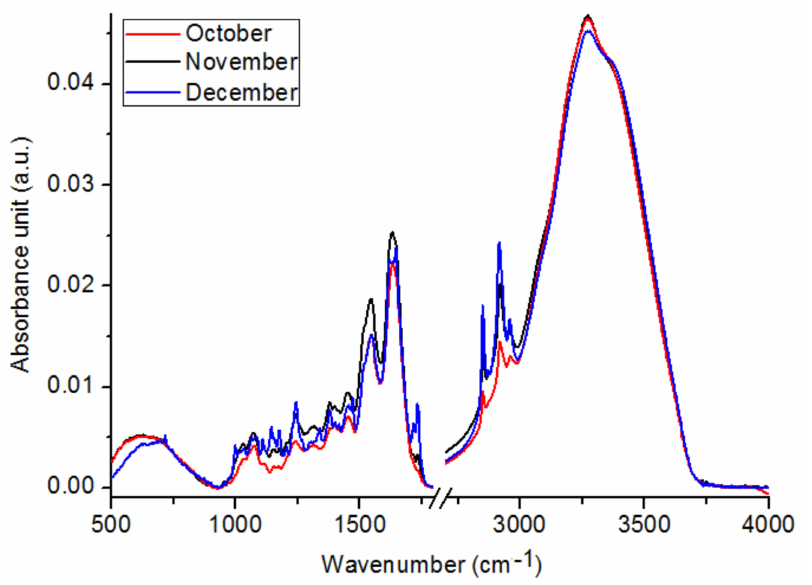
Figure 3. FTIR spectra of October (red spectrum), November (black spectrum) and December (blue spectrum) of C. tujafilina